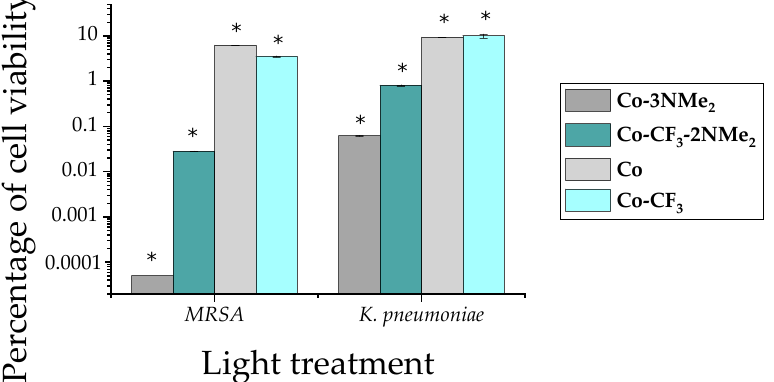
Figure 4. Cell survival profile of MRSA and K. pneumoniae upon light exposure. The bar plot illustrates the percentage of cell viability related to bacteria exposed solely to light (control). The following colors represent each compound: dark gray, Co-3NMe 2 ; dark cyan, Co-CF 3 -2NMe 2 ; light gray Co; and light cyan Co-CF 3 . Results are represented as the mean ± standard deviation of 3 replicates performed on three independent days. Row data of light treatments are shown in Figure S13. Dark experiments were run in parallel (Figure S14). * represents a p -value of 0.05 or lower which is considered statistically significant with respect to the